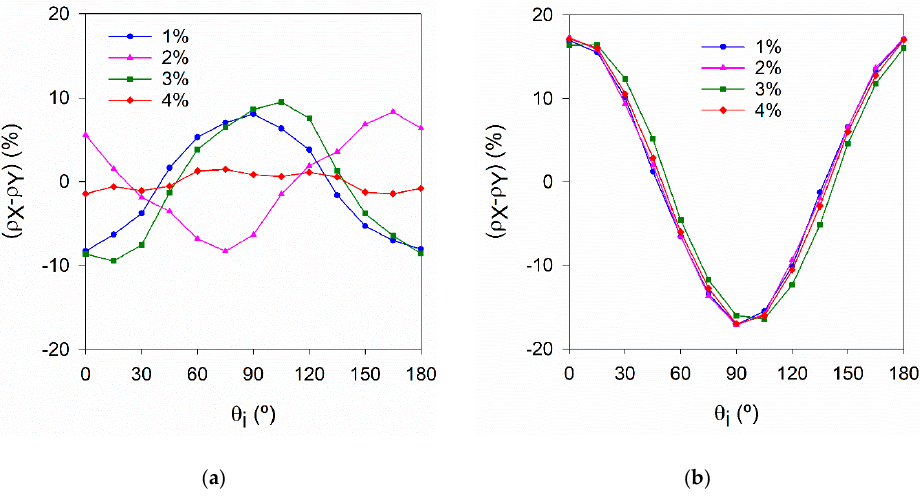
Figure 13. Variation of μ r with the measuring direction for ( a ) HRM_i and ( b ) HOM_i specimens (moulded surface).